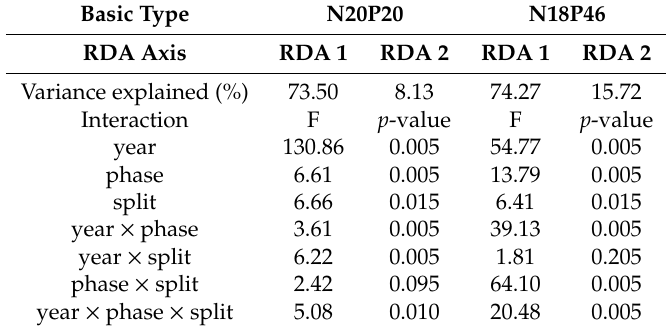
Figure 3. Redundancy analysis (RDA) of arbuscular mycorrhiza colonization in winter wheat, separated by year, basic fertilization, and yield potential: ( a ) N20P20; ( b ) N18P46. (A) 2014–2015; (B) 2015–2016; (C) 2016–2017. AN, ammonium nitrate (N—34%); CAN, calcium ammonium nitrate (N—27%); urea (N—46%). Table 3. The importance of experimental factors in arbuscular mycorrhiza development in winter wheat.